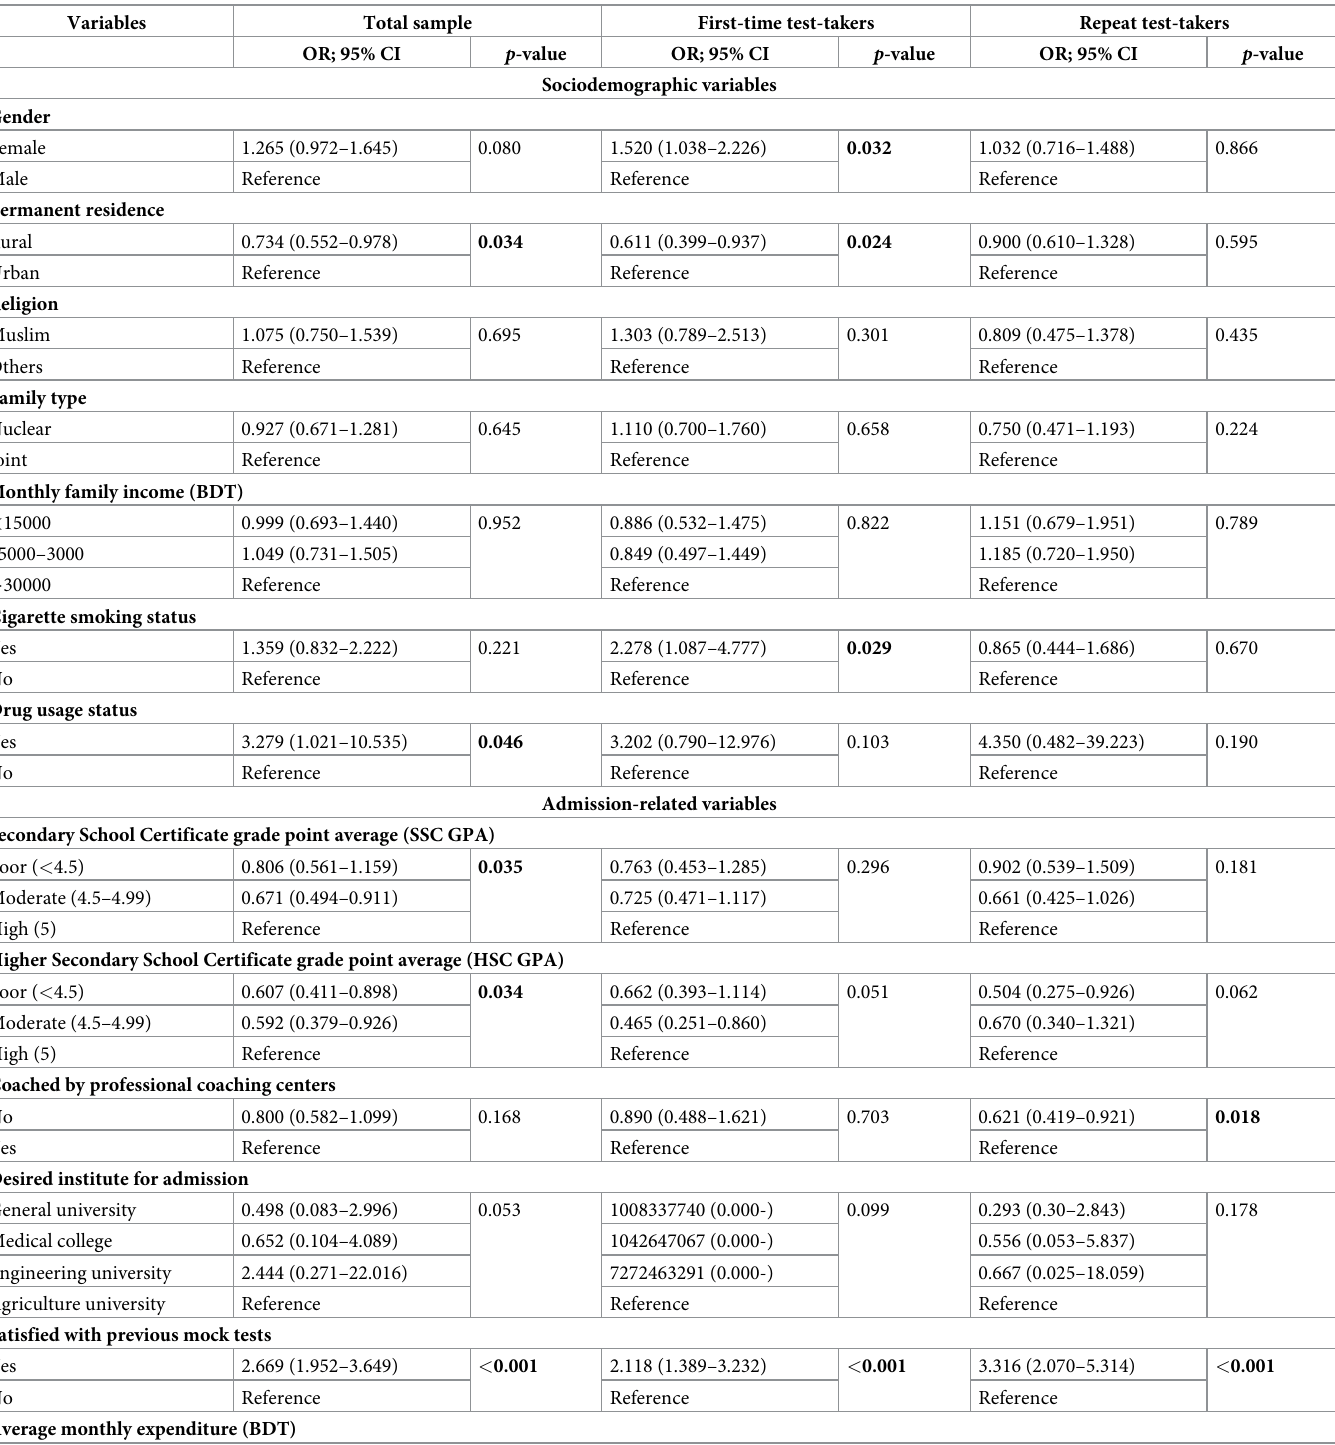
Table 3. Binary logistic regression analysis concerning two-dimensional burnout among first-time and repeat university entrance